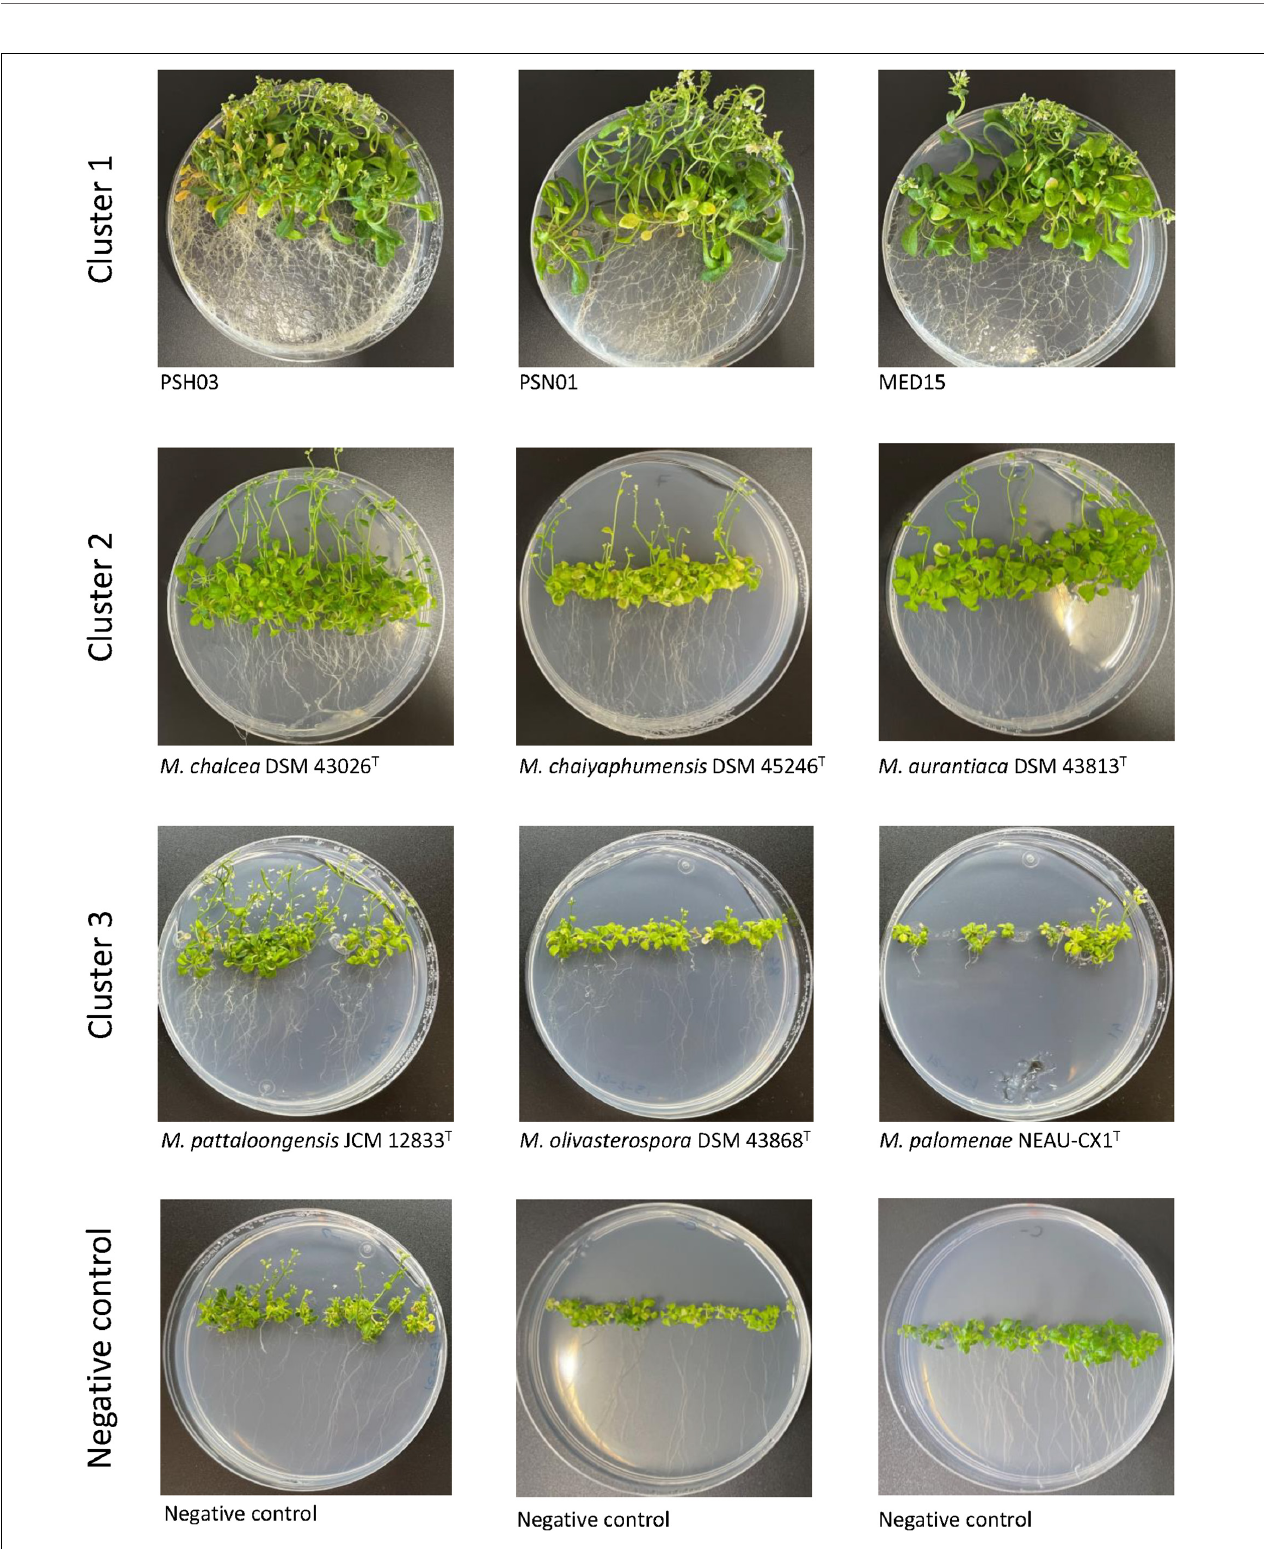
FIGURE 5 | Arabidopsis thaliana plants after 4 weeks of growth and inoculated with strains from Cluster 1 (MED15, PSN01, and PSH03), Cluster 2 ( M. aurantiaca DSM 43813 T , M. chaiyaphumensis DSM 45246 T , and M. chalcea DSM 43026 T ), and Cluster 3 ( M. pattaloongensis JCM 12833 T , M. palomenae DSM 102131 T , and M. olivasterospora DSM 43868 T